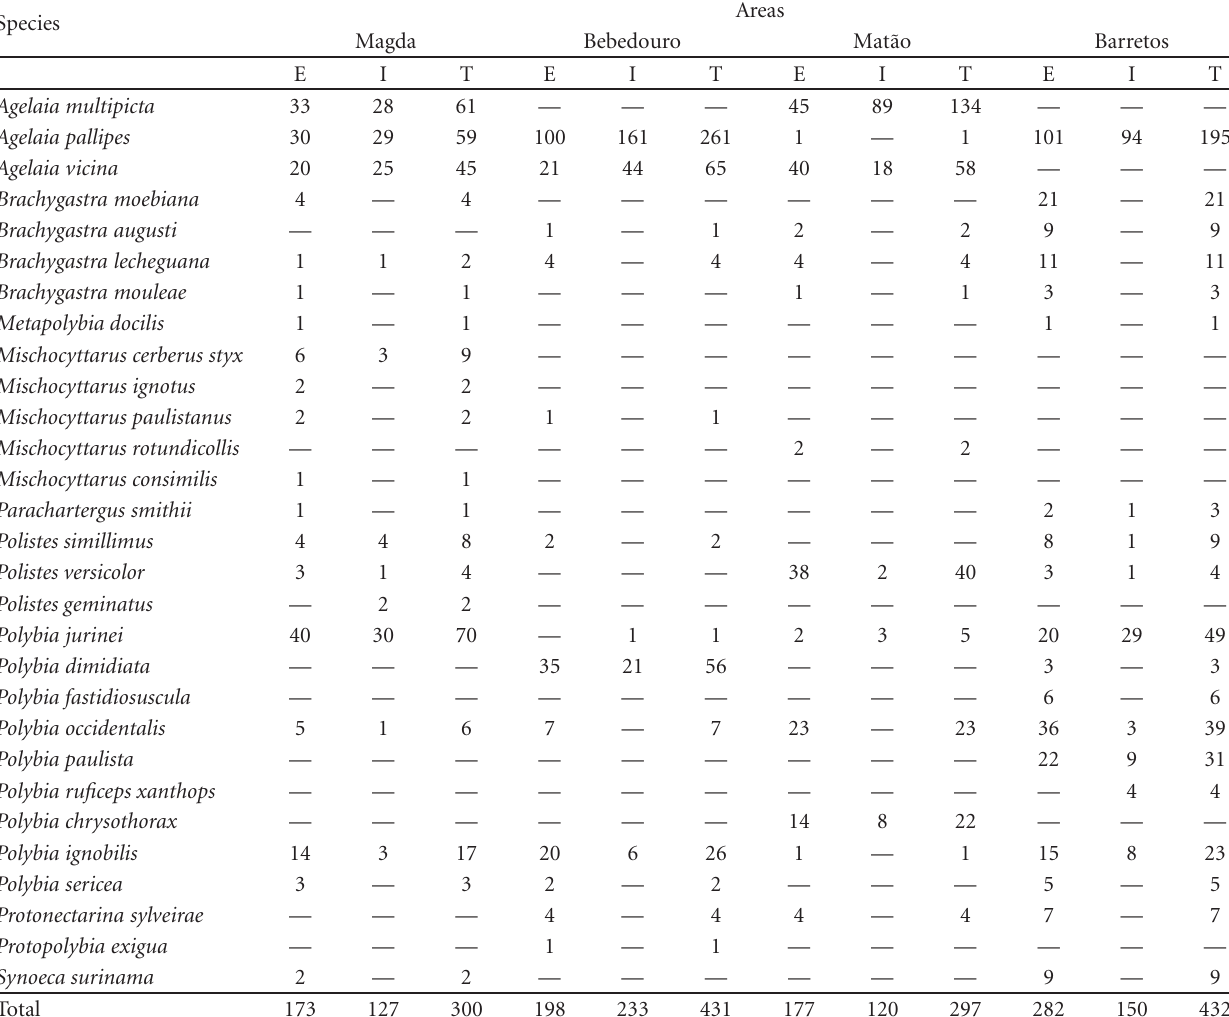
Table 1: List of social wasps species collected on the four areas studied. E: edge; I: interior; T: total. Magda and Bebedouro: sugarcane crops. Mat˜ao and Barretos: citrus crops.